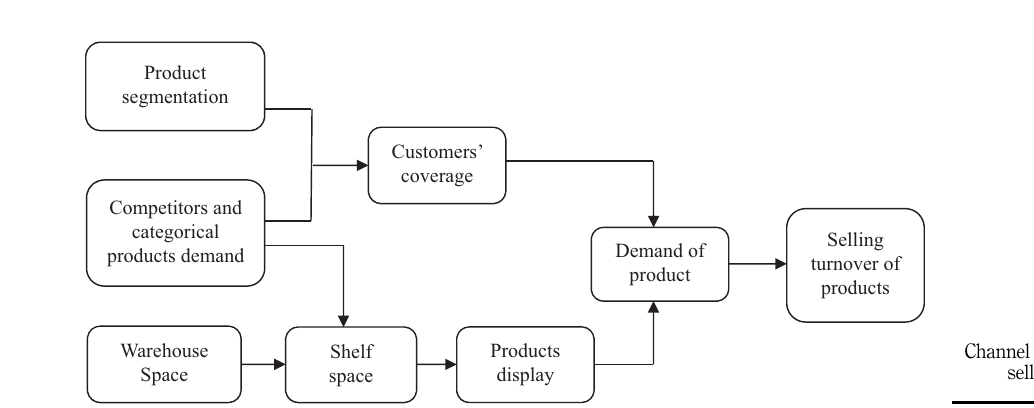
Figure 2. The effectiveness of